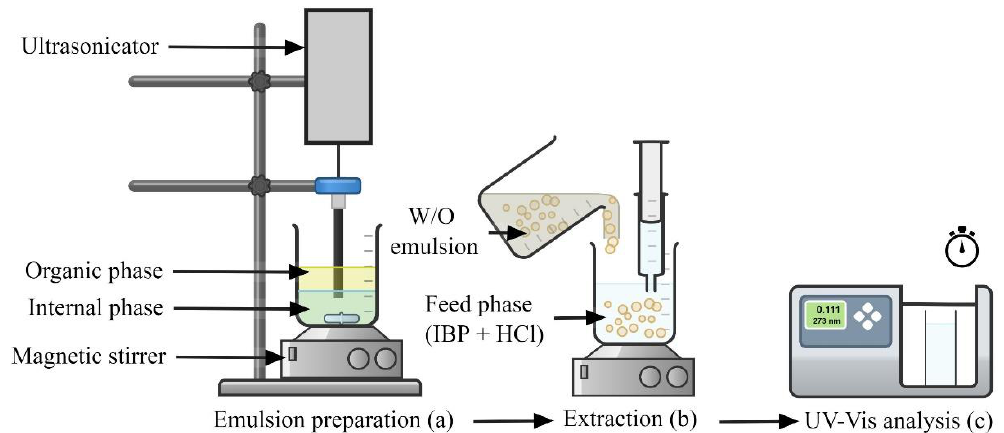
Figure 2. Schematic diagram of ( a ) emulsion preparation; ( b ) IBP extraction; ( c ) UV-Vis analysis.